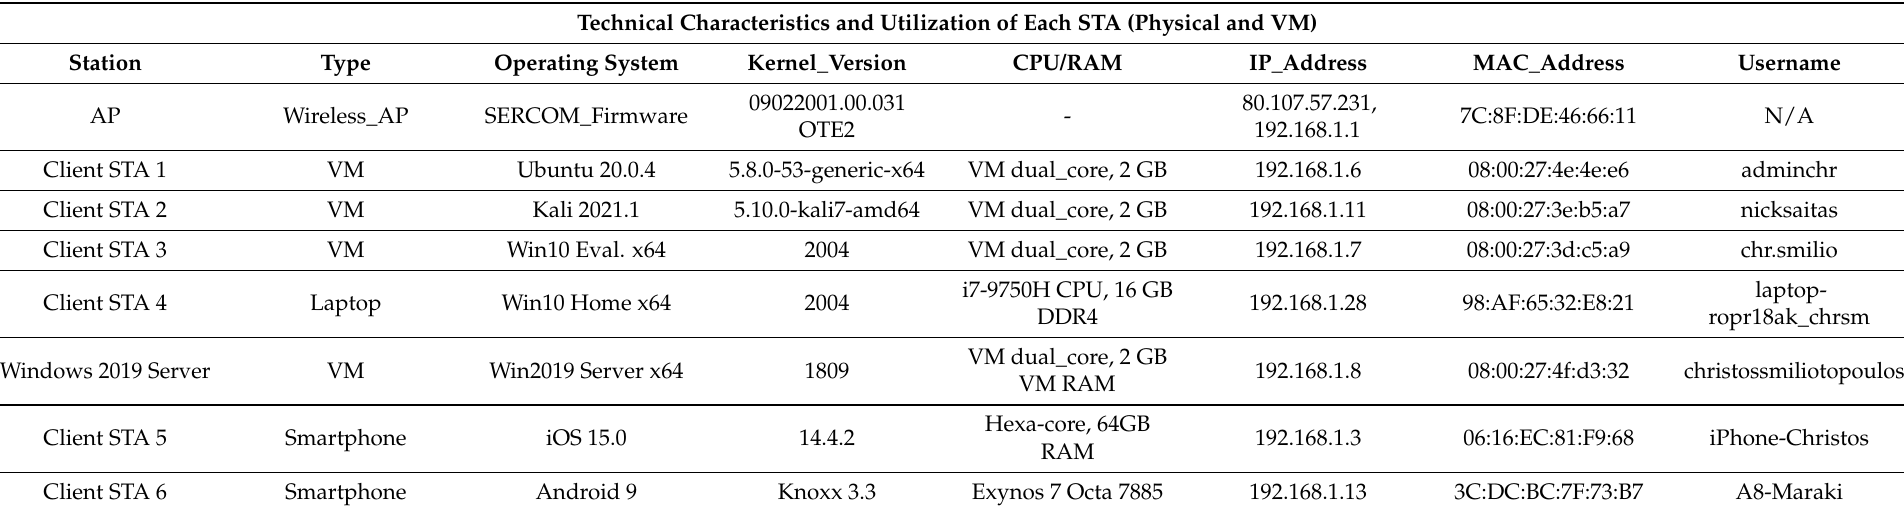
Table 2. Summary of key technical characteristics related to the machines utilized during the execution of the LM experiments. Technical Characteristics and Utilization of Each STA (Physical and